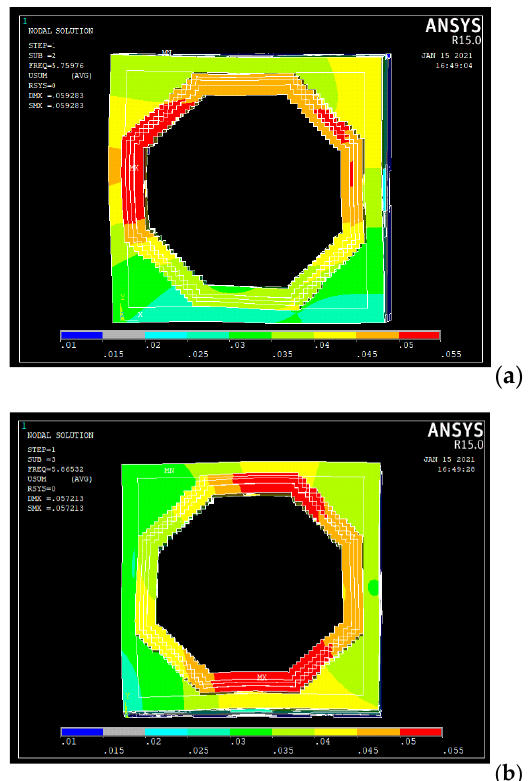
Figure 14. Mode shapes: ( a ) second mode; ( b ) third mode.